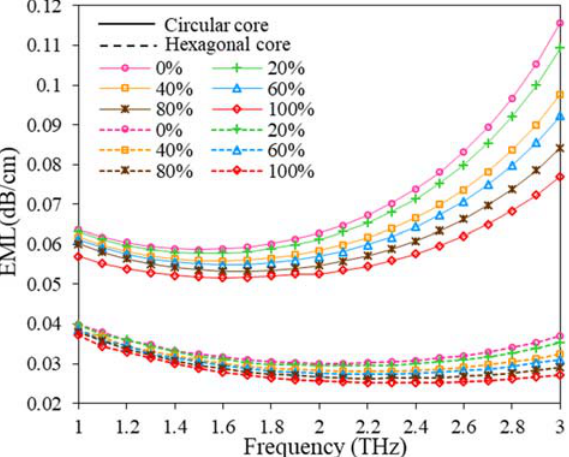
Figure 11. EML variation with the change of frequency for D = 643.34 μ m, D c = 280 μ m, t = 15 μ m, z = 10 μ m.